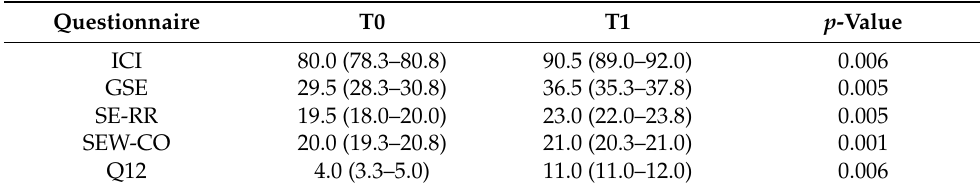
Table 2. Statistical comparisons of clinical scores between baseline (T0) and follow-up (T1). Scores are in median (first–third quartiles); Significant differences between treatment effects are in bold. ICI = Interpersonal Communication Inventory; GSE = General Self-Efficacy Scale; SEW-RR = Scale of Perceived Self-Efficacy at Work—relational readiness; SEW-CO = Scale of Perceived Self-Efficacy at Work—commitment; Q12 = ad hoc 12-item questionnaire.